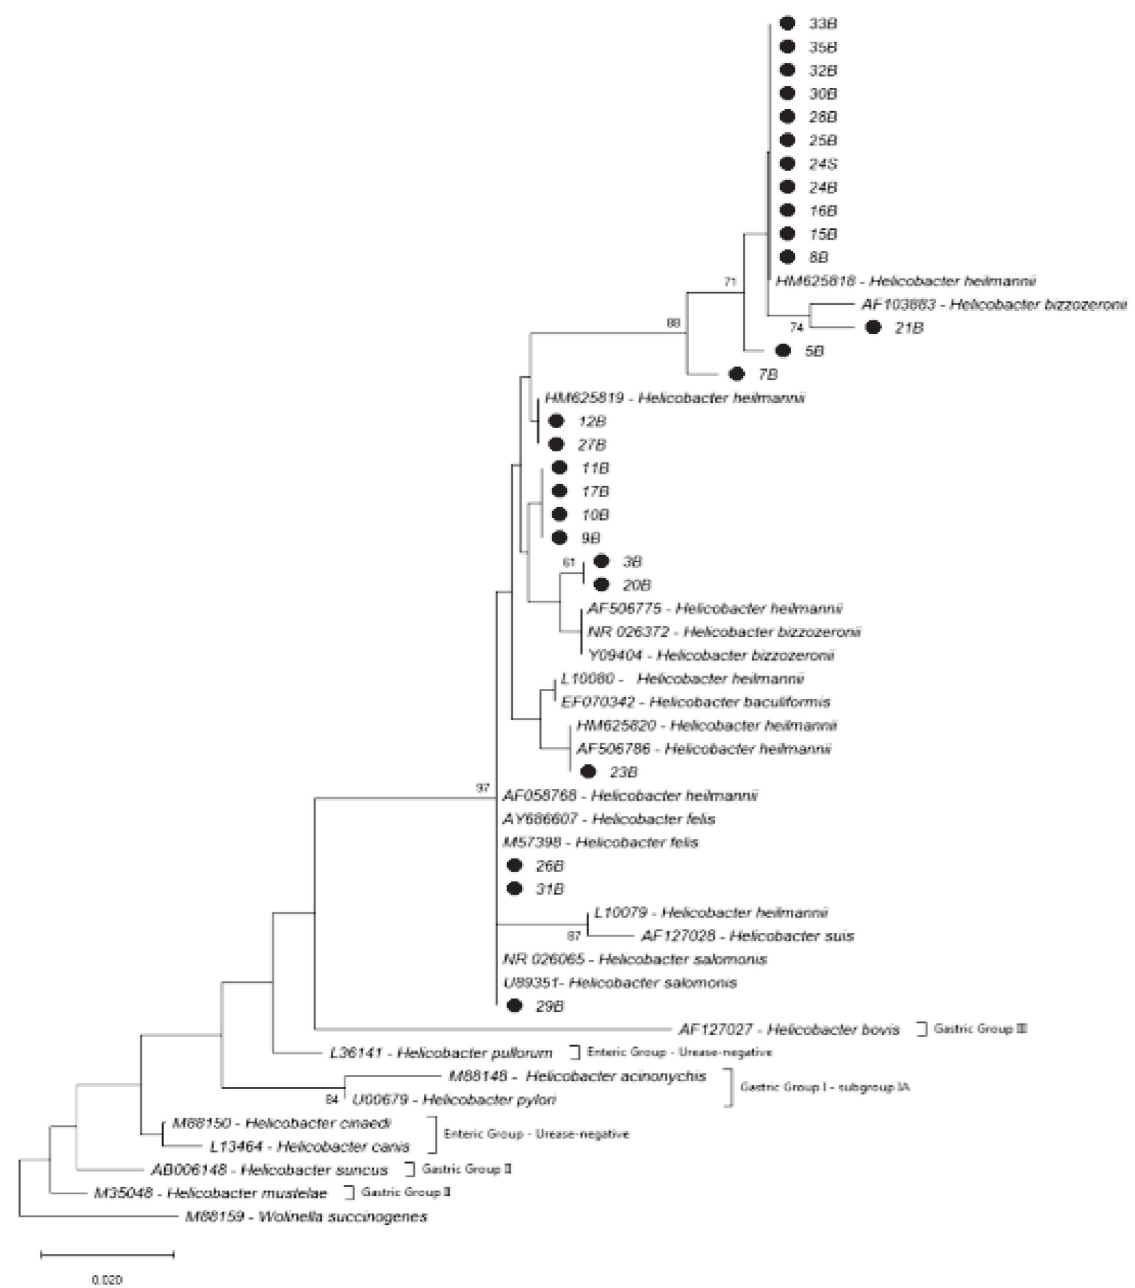
Figure 3: Phylogenetic tree based in the nucleotide sequence of 16S rRNA gene of Helicobacter spp. The tree was build employing the Neighbor-Joining method with a bootstrap of 1000 replicates. The evolutionary distances were computed using of Kimura-2 method. Values above 60% are showed. The sequences obtained of this study are highlighted with a black circle; n ° B, animal number/gastric biopsy sample; n ° S, animal number/saliva